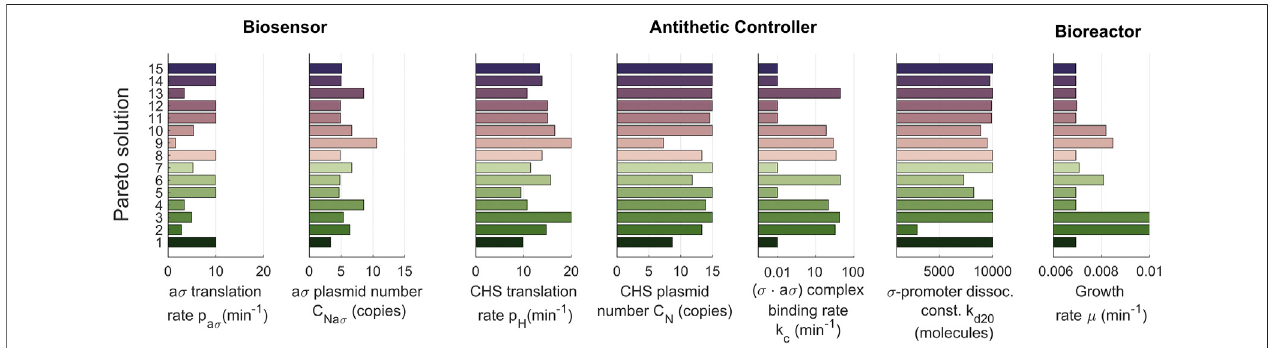
FIGURE 6 | Library of optimal controller-biosensor devices for the dynamic regulation of the naringenin pathway. Pareto set representing the optimal tuned values ofthecontroller-biosensorparameters(decisionvariables).Onthe x -axisweshowtheoptimalvaluesoftheparametersforeachsolution.Eachoneofthesolutions(inthe y -axis) constitutes an element of the controller-biosensor library. The color code is the same as the one used in Figure 5 .